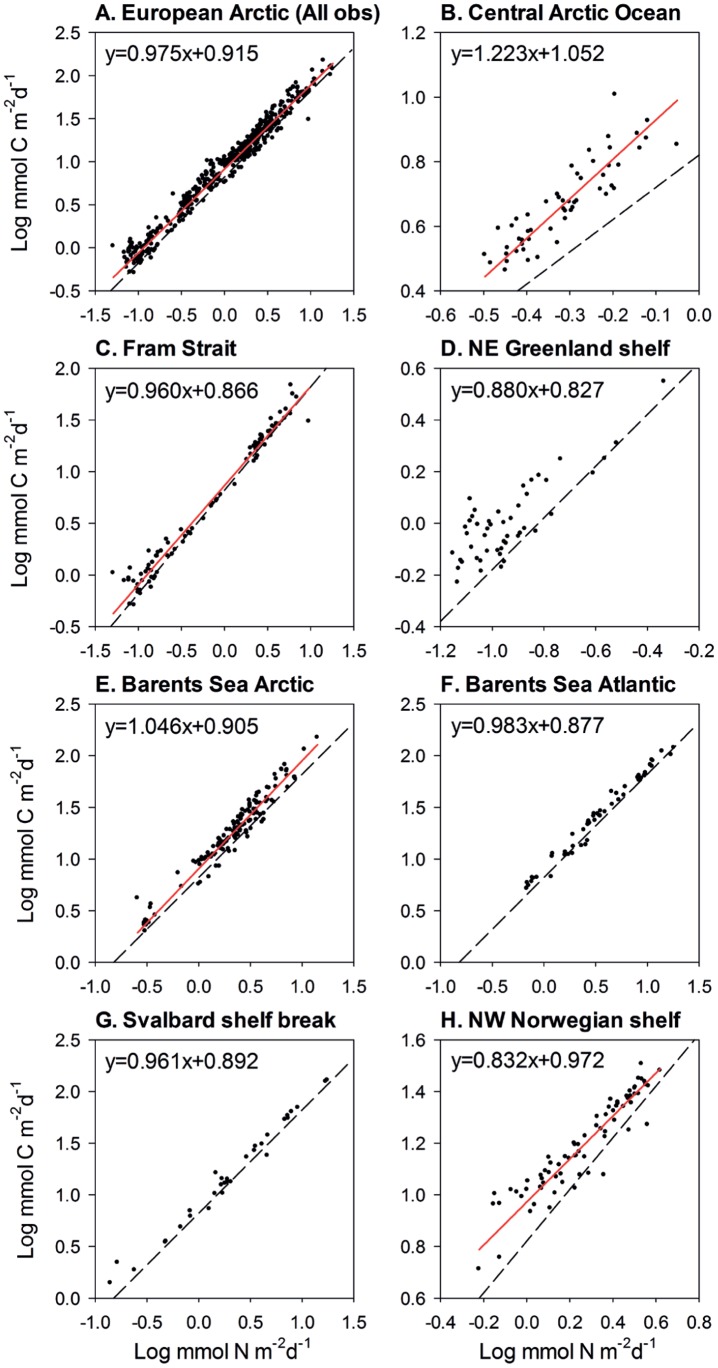
Relationships between vertical flux of POC and PON in the European Arctic Ocean.Log-log plots of POC on PON (log mmol m−2 d−1) and Standard Major Axis regressions based on all data (A) and for each sub-region (B–H). Regressions with slope significantly different from one are indicated by red lines. The stippled line indicates the Redfield C:N ratio. Regression coefficients with confidence intervals are given in Table 4.